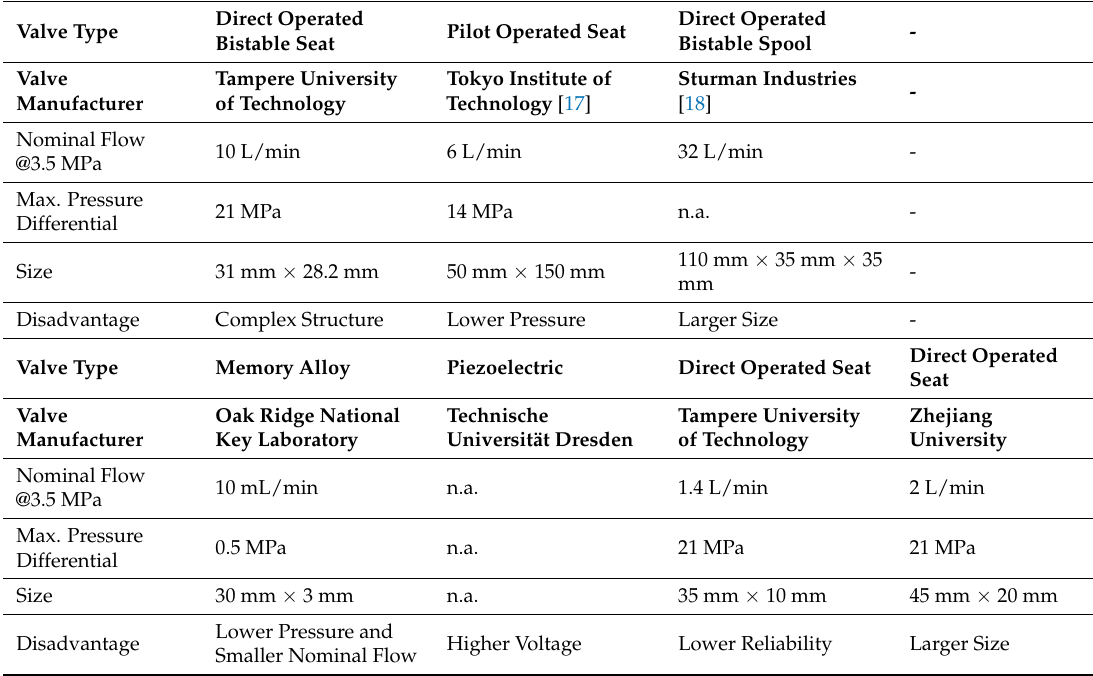
Table 1. Characteristics of the valves.